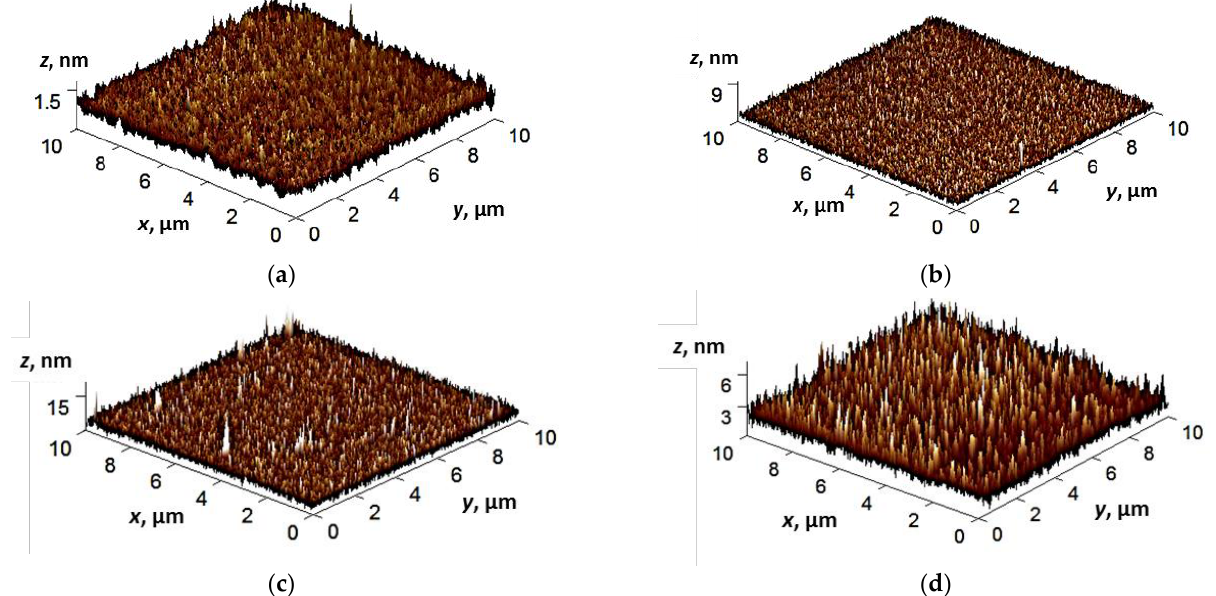
Figure 3. 3D AFM images of the surface of the LPCVD films deposited at ( a ) 673, ( b ) 873, ( c ) 973 K, and ( d ) of the PECVD film obtained at T dep = 523 K. Scanning area is 10 × 10 μm 2 . Previously, we studied the temperature dependence of the RMS roughness of PECVD BC x N y films deposited using a mixture of trimethylborazine and nitrogen. The roughness varied from 0.5 to 2.6 nm with an increase in T dep from 373 to 973 K [58]. Other authors [55] observed the same trend for LPCVD BC x N y films. An increase in the RMS roughness from 0.3 nm to 0.5 nm with an increase in temperature from 633 K to 773 K was found for films deposited using a mixture of dimethylamine borane and ammonia. Figure S2 shows the X-ray diffraction patterns of Si(100) substrate, the 190 nm thick film deposited at T dep = 973 K and the 270 nm thick film deposited at T dep = 523 K by LPCVD and PECVD, respectively. XRD patterns of films are similar to those of the substrate. They contain no reflexes, which indicates the amorphous nature of these films. The only peak at 2θ = 33° corresponds to the Si(200) forbidden reflection of a substrate [59]. In other stud- ies [40,41], BC x N y films deposited from TMAB were also found to be amorphous. 3.3. Films’ Composition and Chemical Bonding State The quantitative compositional information on the surface and volume of a layer is a basic measurement of importance to the design and performance diagnosis of thin films. The films’ compositions were evaluated using analysis methods such as energy disper- sive, Raman, FTIR and X-ray photoelectron spectroscopy. 3.3.1. EDX Spectroscopy Data The EDX spectra confirmed the presence of boron, carbon, nitrogen, and oxygen. Ex- perimental chemical maps based on EDX data show uniform elemental distribution over the sample’s site. Figure 4 shows the data for two films obtained by LPCVD (T dep = 973 K) and PECVD (T dep = 373 K) and having B 0.67 C 0.24 N 0.08 O 0.01 and B 0.22 C 0.36 N 0.19 O 0.24 compositions , respectively.